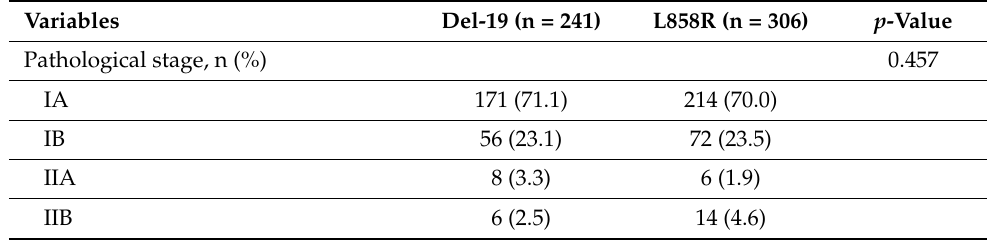
Figure 3. Kaplan – Meier curve of EGFR wild type, Exon 19 deletion, and L858R overall survival. 4. Discussion In our study population, 60% of patients had EGFR mutations. This is similar to the results of previous studies [11,22]. Our study showed that the EGFR mutation group was